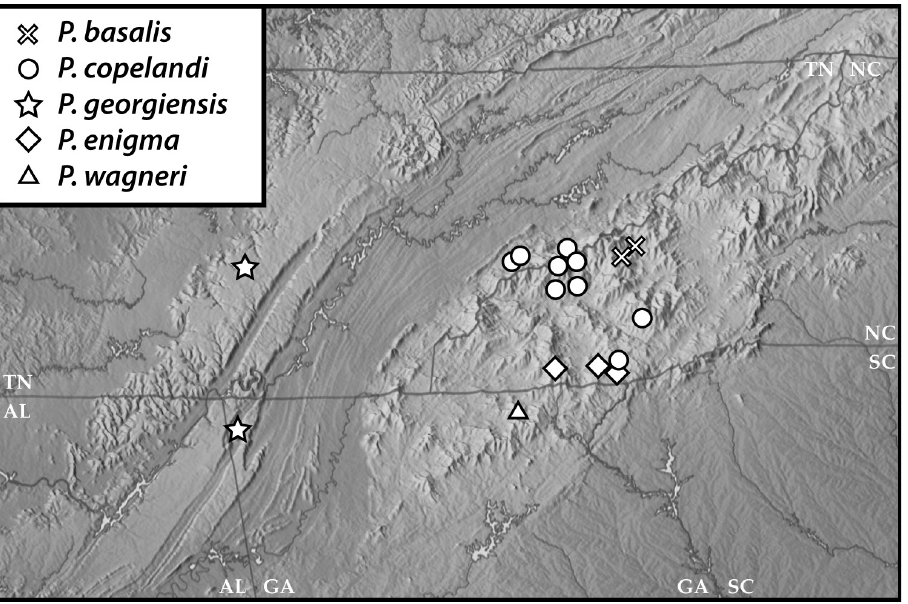
Figure 50. Map of southern Appalachia with specimen records for P. basalis , P. copelandi , P. georgensis , P. enigma , and P. wagneri